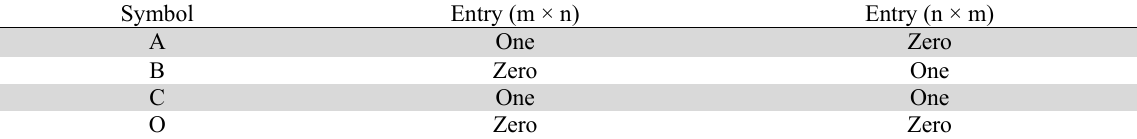
Conversion of entries of reachability matrix Symbol Entry (m ×